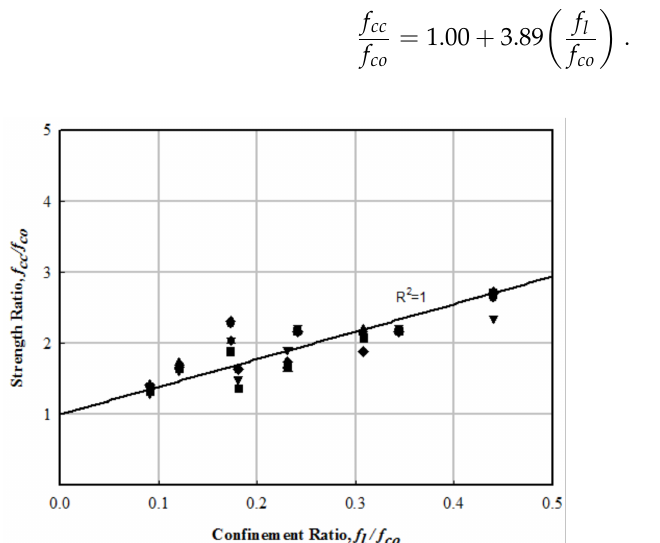
Figure 19. Relationship between strength ratio and confinement ratio of the hybrid −